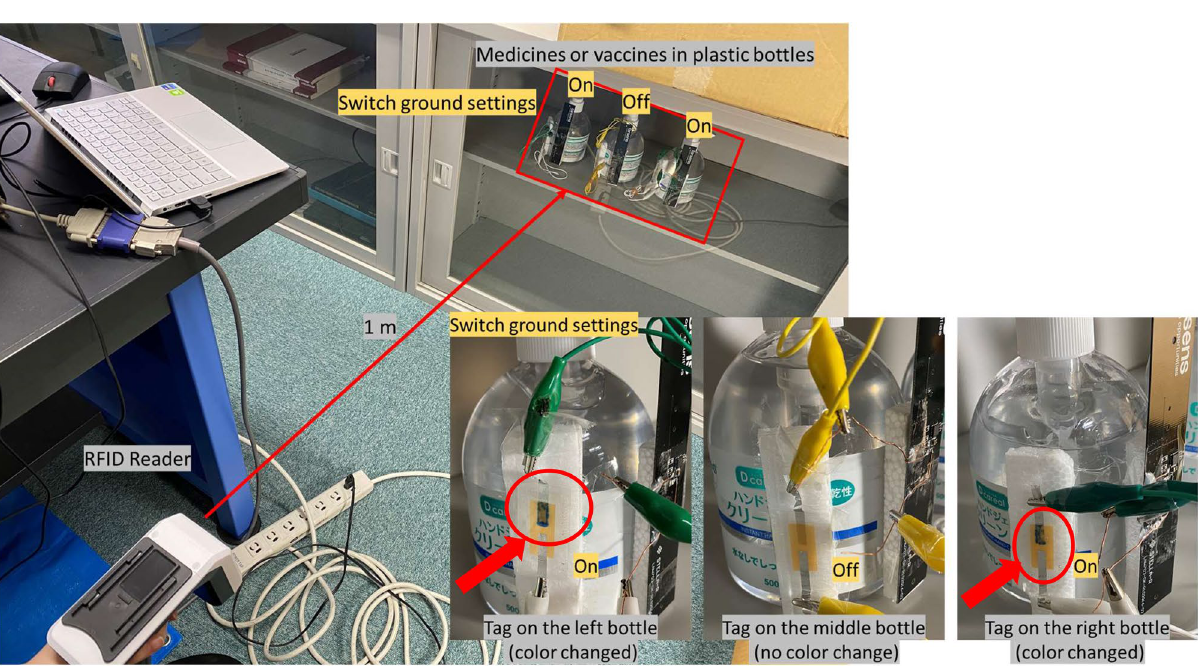
Figure 3. Demonstration of an IoMT application for managing sanitizers in plastic bottles after 30 s of management (RFID reader irradiation). The left and right sanitizers are set as the targets (Switch ground setting = ‘on’). The color-change positions are specified by red arrows and